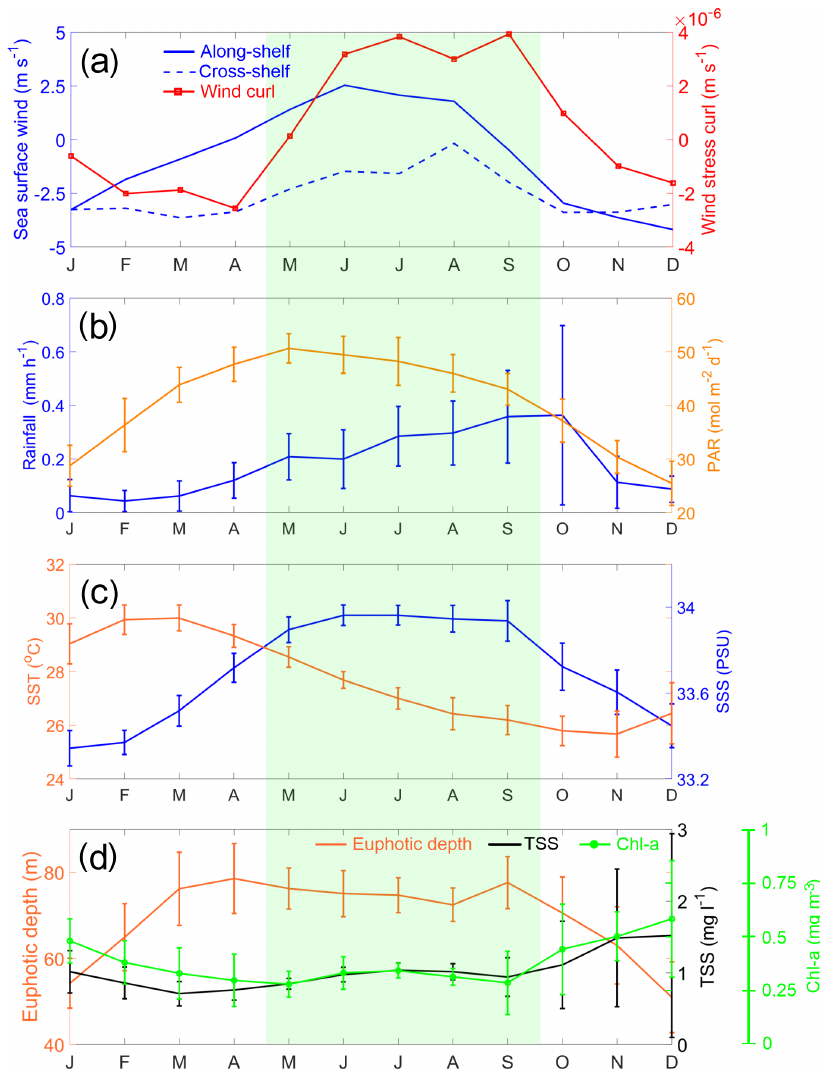
Figure 2. Monthly climatological (a) sea surface wind and wind stress curl, (b) rainfall and PAR, (c) SST and SSS, and (d) euphotic depth, Chl a , and TSS in the study area. The error bar indicates the standard deviation (STD). The shaded area indicates the upwelling